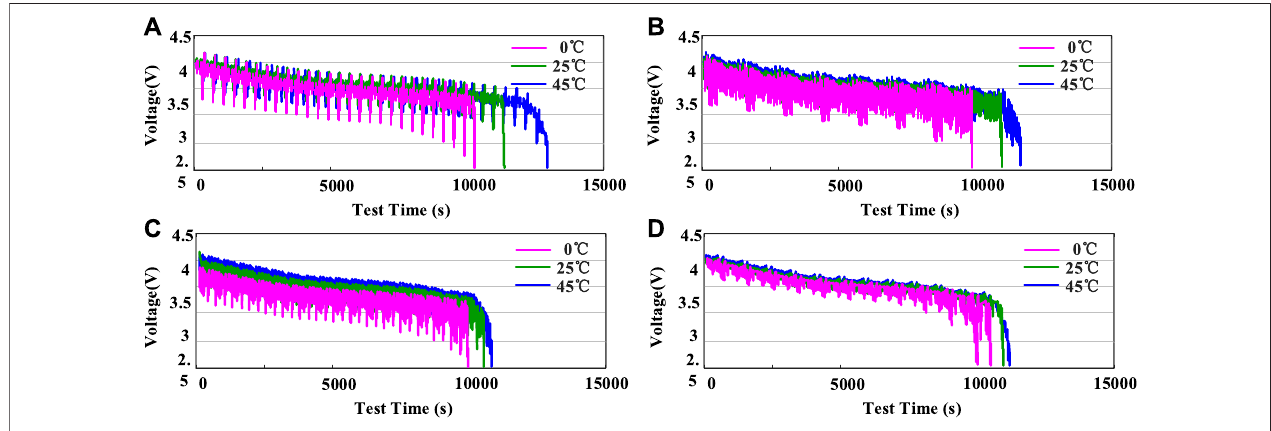
FIGURE 6 | Voltage distribution at 0 ° C, 25 ° C, and 45 ° C: (A) DST, (B) FUDS, (C) US06, and (D) BJDST.